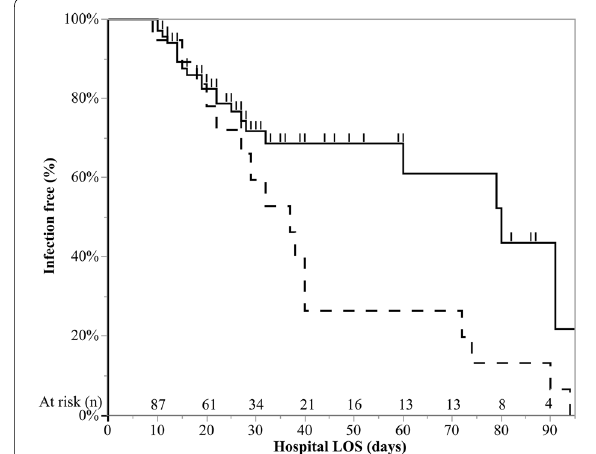
Fig. 1 Probability of being colonization-free. Kaplan–Meier estimates of the unadjusted cumulative probability of being colonization-free (tracked line). Tick marks represent censored patients